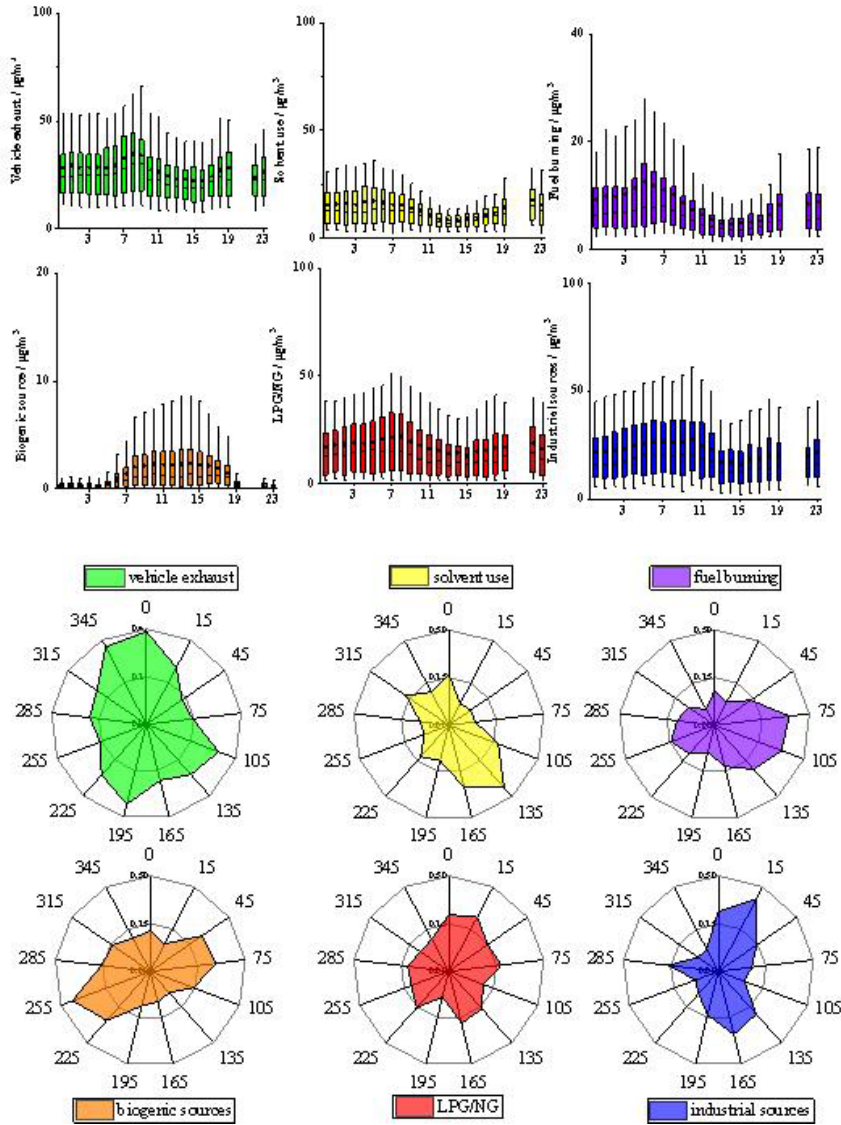
Figure 5. Conditional probability function (CPF) plots of local VOC sources in Zhengzhou. The mean (dot), median (horizontal line), 25th and 75th percentiles (lower and upper box), and 10th and 90th percentiles (lower and upper whiskers) for the entire study are